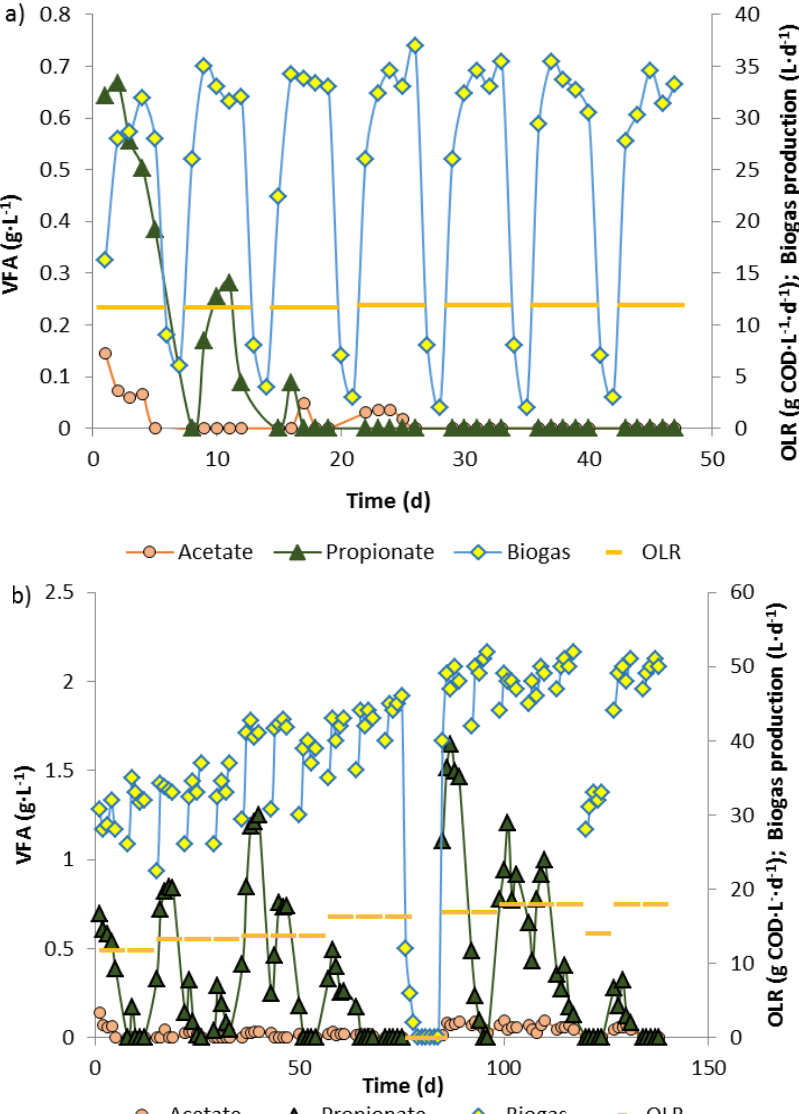
Figure 2. Biogas production and fatty acid levels in a 10 L biowaste reactor 1 after start at an OLR of 12 kg COD biowaste ·m −3 ·d −1 ( a ) and in reactor 2 for increasing organic loading rates up to 18 kg COD·m −3 ·d −1 , maintained by 12 kg (day 1–55) or 14 kg (new batch biowaste from day 55 onwards) COD biowaste ·m −3 ·d −1 plus respective amounts of propionate ( b ). No feeding between days 75–85 due to maintenance